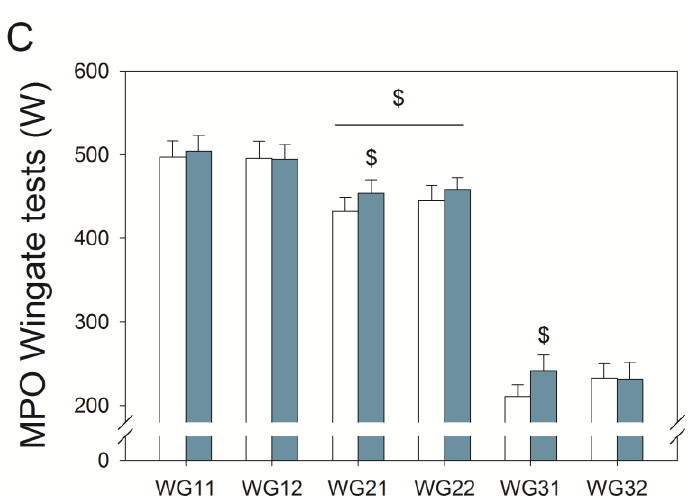
Figure 2. Performance during the sprint exercise after the ingestion of polyphenols (mangiferin + luteolin) or placebo. ( A ) Peak power output in 15 s sprints performed after ischemia. ( B ) Mean power output during the first 5 s during the sprints performed after ischemia. SIE: first sprint after incremental exercise, SSIE: second sprint after incremental exercise. Number 1 indicates after 48 h and 2 after 15 days of supplementation. ( C ) Mean power output during the 30 s Wingate test. WG: Wingate test, the first number represents the Wingate order number (1, 2, or 3), the second number (1 or 2) indicates after 48 h and 2 after 15 days of supplementation, respectively. * p < 0.05 compared with 48 h test in the same condition. $ p < 0.05 for treatment effect. ANOVA Wingate × time × treatment interaction, p = 0.027. N = 12.